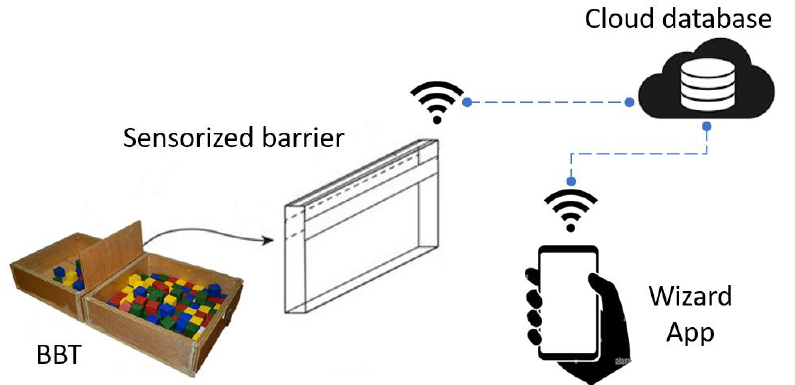
Figure 2. Proposed system for automatic cube counting based on sensorized barrier and Wizard app.